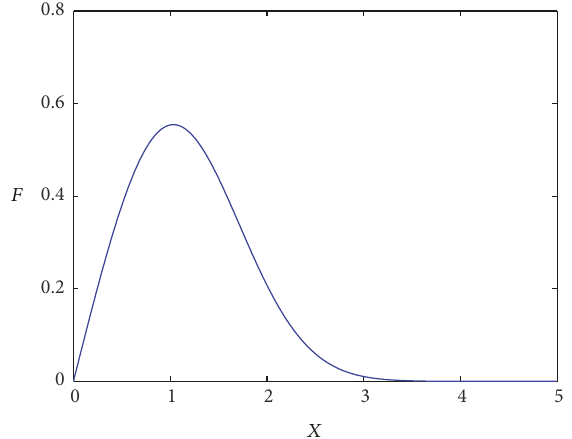
Figure 4: The cross section exhibits resonance behavior. Shown is the resonance properly normalized as a function of 𝑋 = )√2(𝜖/𝑚 (1/𝜐 − 1) . The width is Γ = 1.49 and the location of the 0 ] maximum is at 1.03.